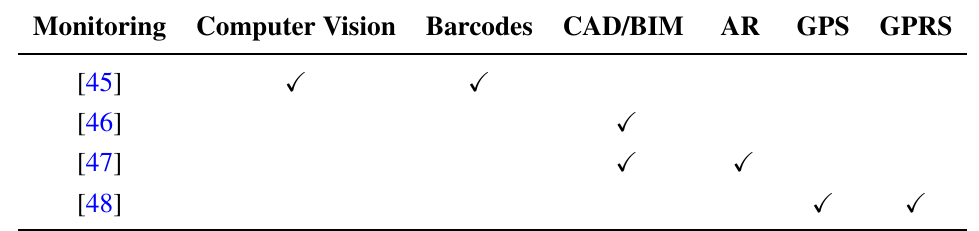
Table 6. Combination of technologies and RFID for construction site monitoring. BIM, building information